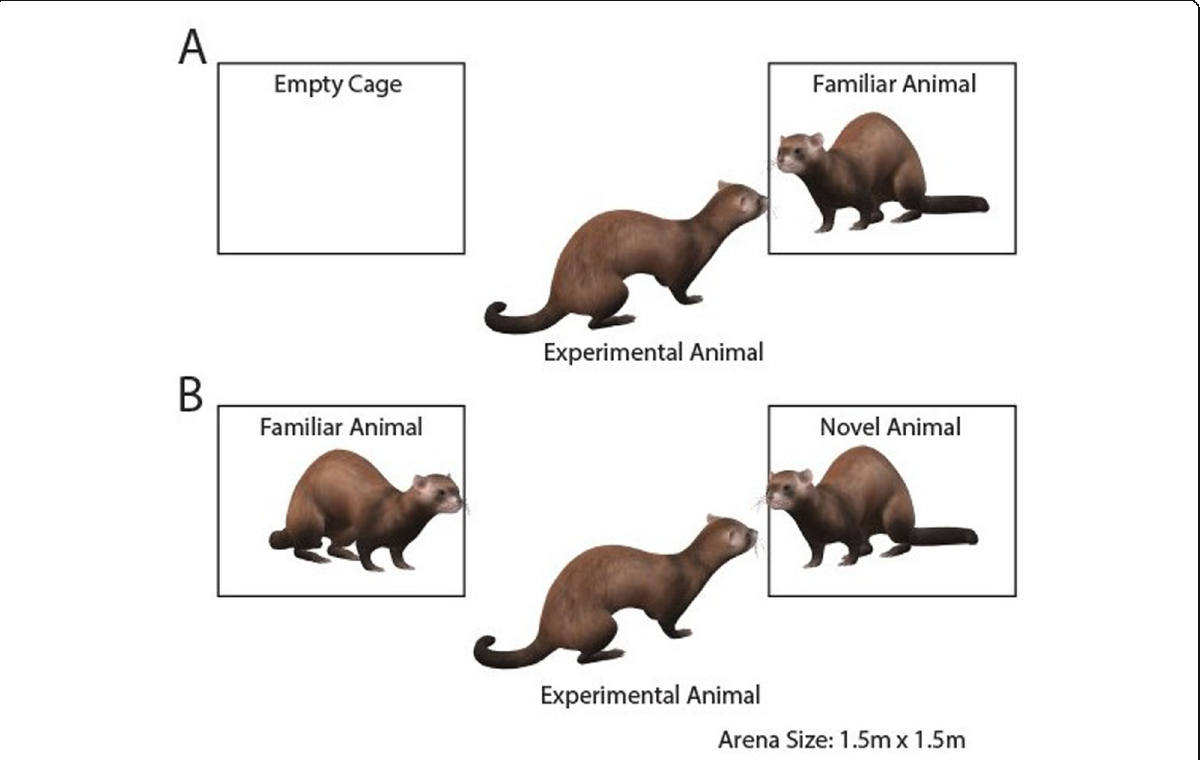
Fig. 1 Picture of the social interaction behavioral test, showing the experimental animal in 2 phases of the paradigm. a depicts the animal socializing with a control animal which will become the familiar animal in ( b) , where the experimental animal can choose to socialize with either the familiar animal from the previous phase or a novel ‘ stranger ’